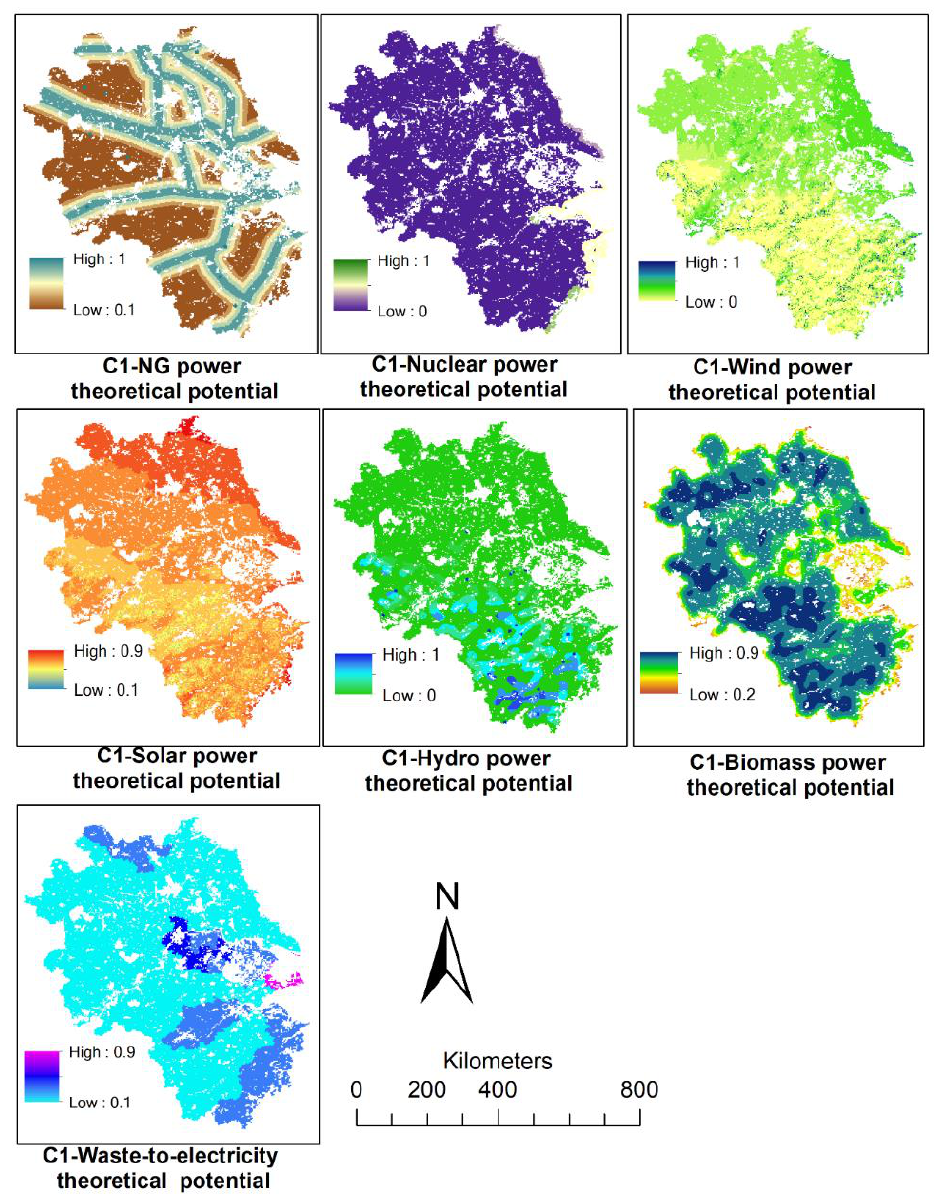
Figure 5. Spatial theoretical energy potential (C1) map of alternative power plants. Unlike C1, determined mainly by different conjunct factors, criteria C2 to C9 only depend on the individual criterion as it is named. Figure 6 shows the resulting map of C2 to C9. From the map, we can easily find that the high suitability indexes of C2 and C3 exist in the flat area of the northeast of the YRD region. It results from the geographic charac- teristic of the northeast of the YRD region, which locates in the middle and lower Yangtze natural alluvial plain. The region is low and flat, so the values of elevation and slope are low, indicating high suitability for power plant siting [25,55]. However, the southwest of the YRD region is covered by hilly areas, which is less suitable for power plant implemen- tation. Except the geographic advantage, the east region is also highly urbanized [77], in- cluding Shanghai, Suzhou, and Hangzhou, and has a well-developed transportation sys- tem and power transmission grids. Therefore, in the map of C4 and C6, east areas are most suitable to implement power plants. To be more specific, most areas of the YRD region are close to the roads, except some hilly areas in the south. By the same token, the north and west are more urbanized and more economically developed with higher population and energy demand [78]. For criteria, C7 and C8, north and east areas have a higher suit- ability index than the south and west areas. In the map of C5 and C9, most of the areas are